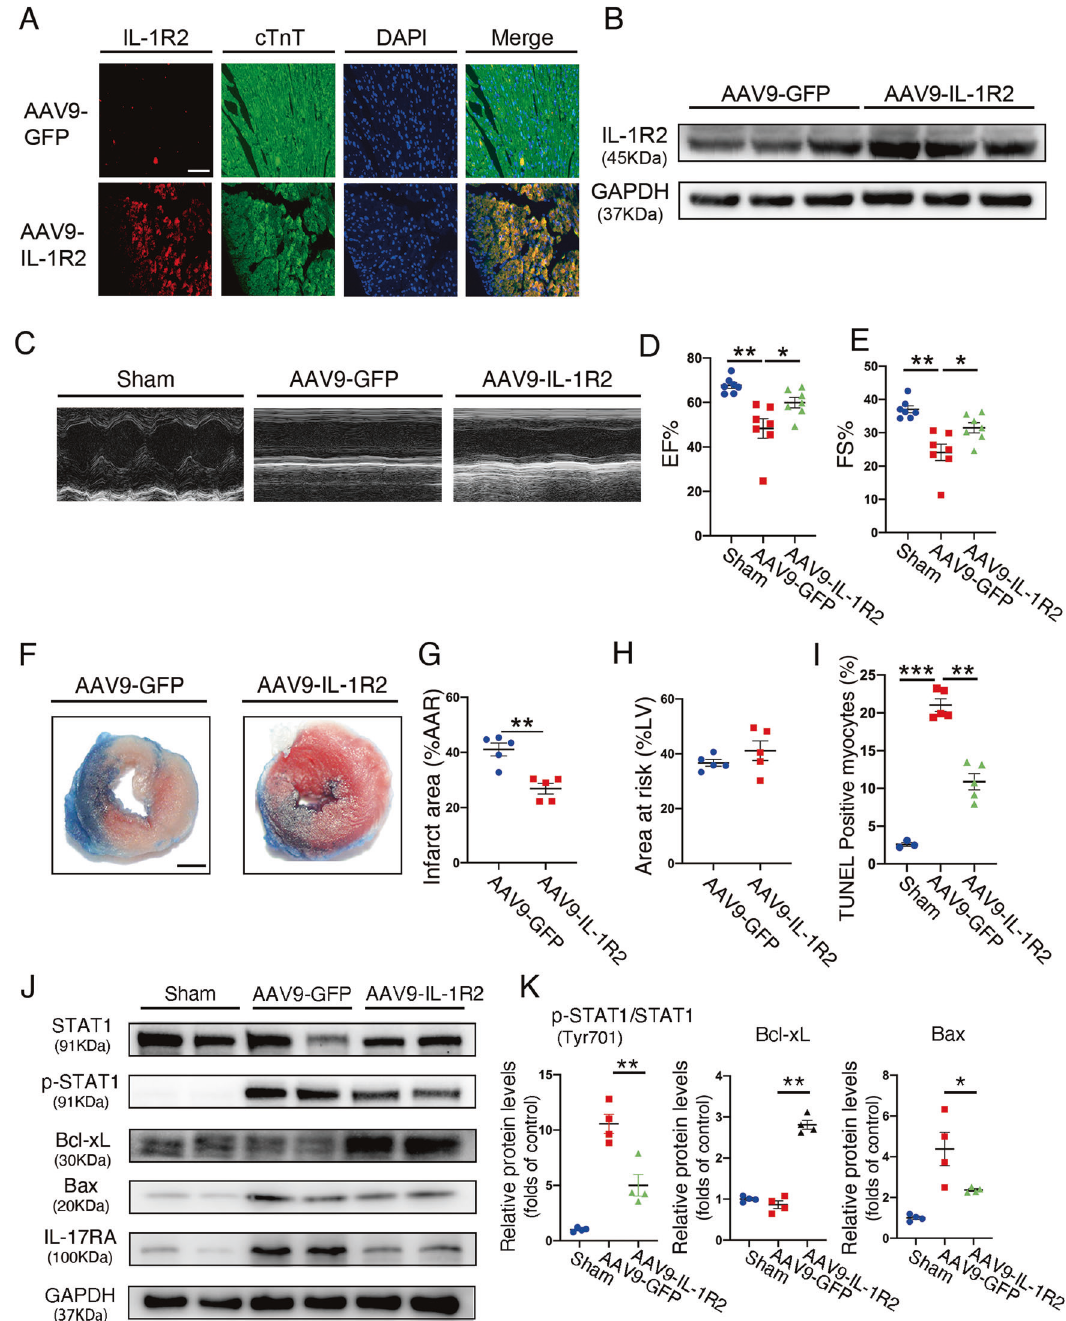
Fig. 6 Overexpression of IL-1R2 in cardiomyocyte protects heart from I/R injury. A, B Representative images and western blots for con fi rming the expression of IL-1R2 in cardiomyocytes with AAV9-GFP and AAV9-IL-1R2 injection. C – E Representative echocardiographic images and quanti fi cation of sham mice ( n = 7), GFP ( n = 7) and IL-1R2-overexpression mice ( n = 7) subjected to myocardial I/R surgery. F – H Representative images of 2,3,5-triphenyltetrazolium chloride staining on mice subjected to myocardial I/R surgery and quanti fi cation of the relative ratios of infarct area to area at risk (border zone) as well as the relative ratios of the area at risk to left ventricle area in the GFP ( n = 5) and IL-1R2 – overexpressing ( n = 5) groups; Scale bar: 1 mm. I Quantitation of TUNEL staining on the heart sections from the Sham ( n = 3), GFP ( n = 5), and IL-1R2 – overexpressing ( n = 5) mice subjected to myocardial I/R surgery. Scale bar: 100 µm. J, K Representative western blots and quanti fi cation of Stat1, p-Stat1, Bcl-xL, Bax, and IL-17RA expression in the hearts from Sham, GFP, and IL-1R2 – overexpressing mice subjected to myocardial I/R injury. Scale bar: 100 µm. * P < 0.05 and ** P < 0.01. Two-tailed unpaired Student ’ s t -test for two groups or one-way ANOVA for three groups or